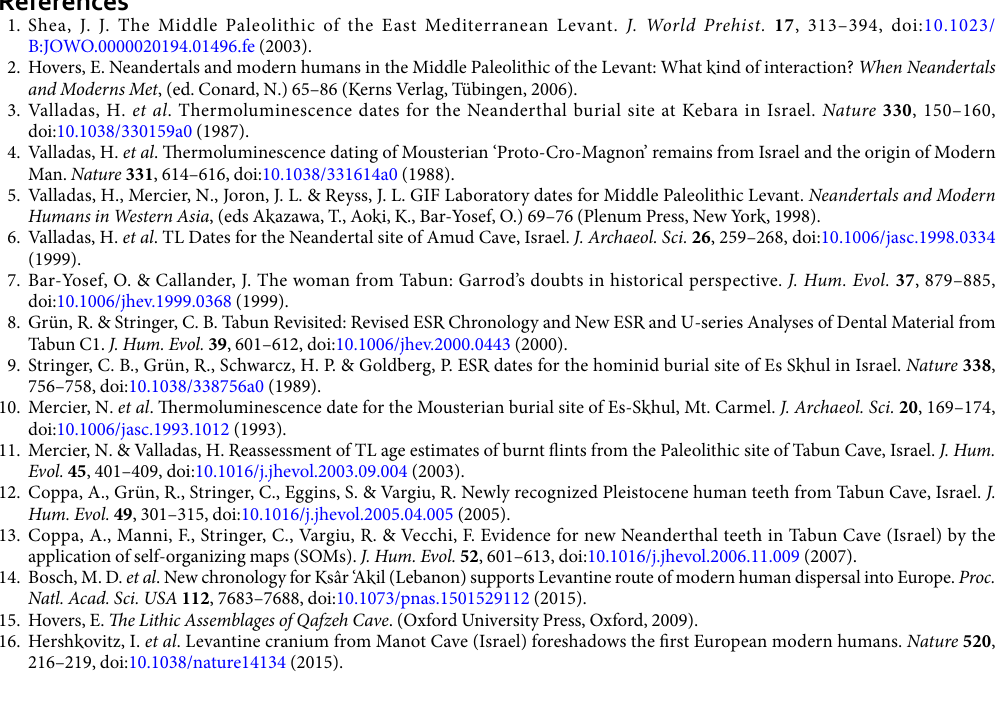
Neandertals (SI 4 Table 5) 33, 69 . The stature estimation was based on 11 formulas: three formulas use femur length, four use tibial length, and four use femoral and tibial length (SI 4 Table 6). EQH3’s stature was compared to that of recent H. sapiens , early H. sapiens , H. neanderthalensis , and the Sima de los Huesos hominins (SI 4 Table